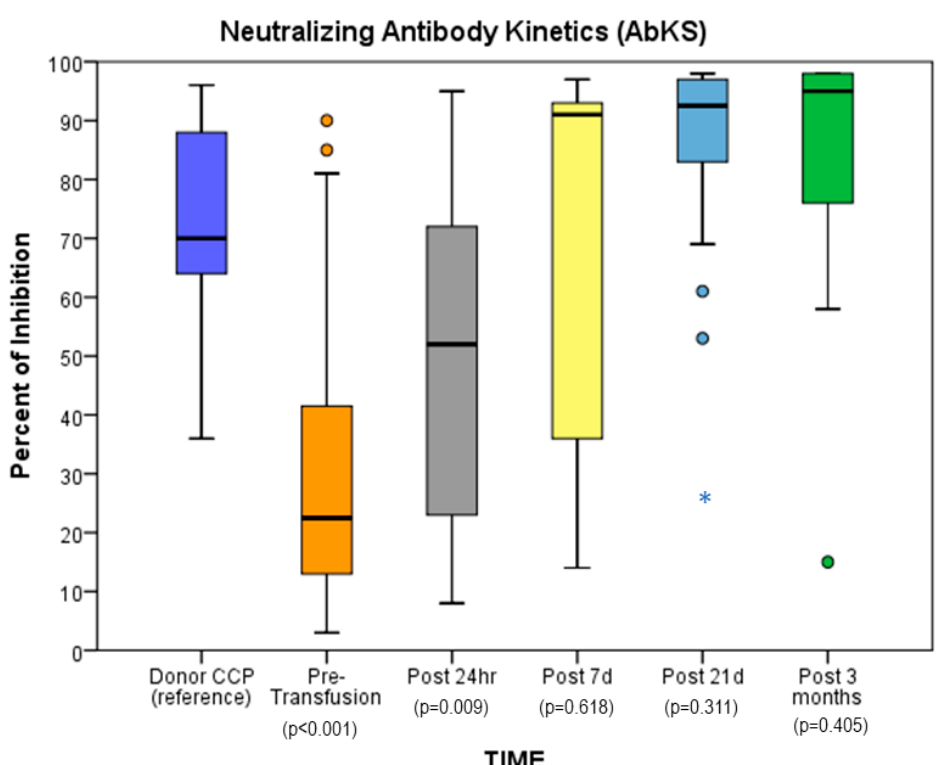
Figure 1. Average percentage of inhibition in relation to donor CCP depended on time since infusion ( p < 0.001), N = 24. Significance based on GEE analyses with the specification of gamma distribution, repeat measures, and independent correlation structure. The dots represent outliers. The asterisk represents an extreme outlier.